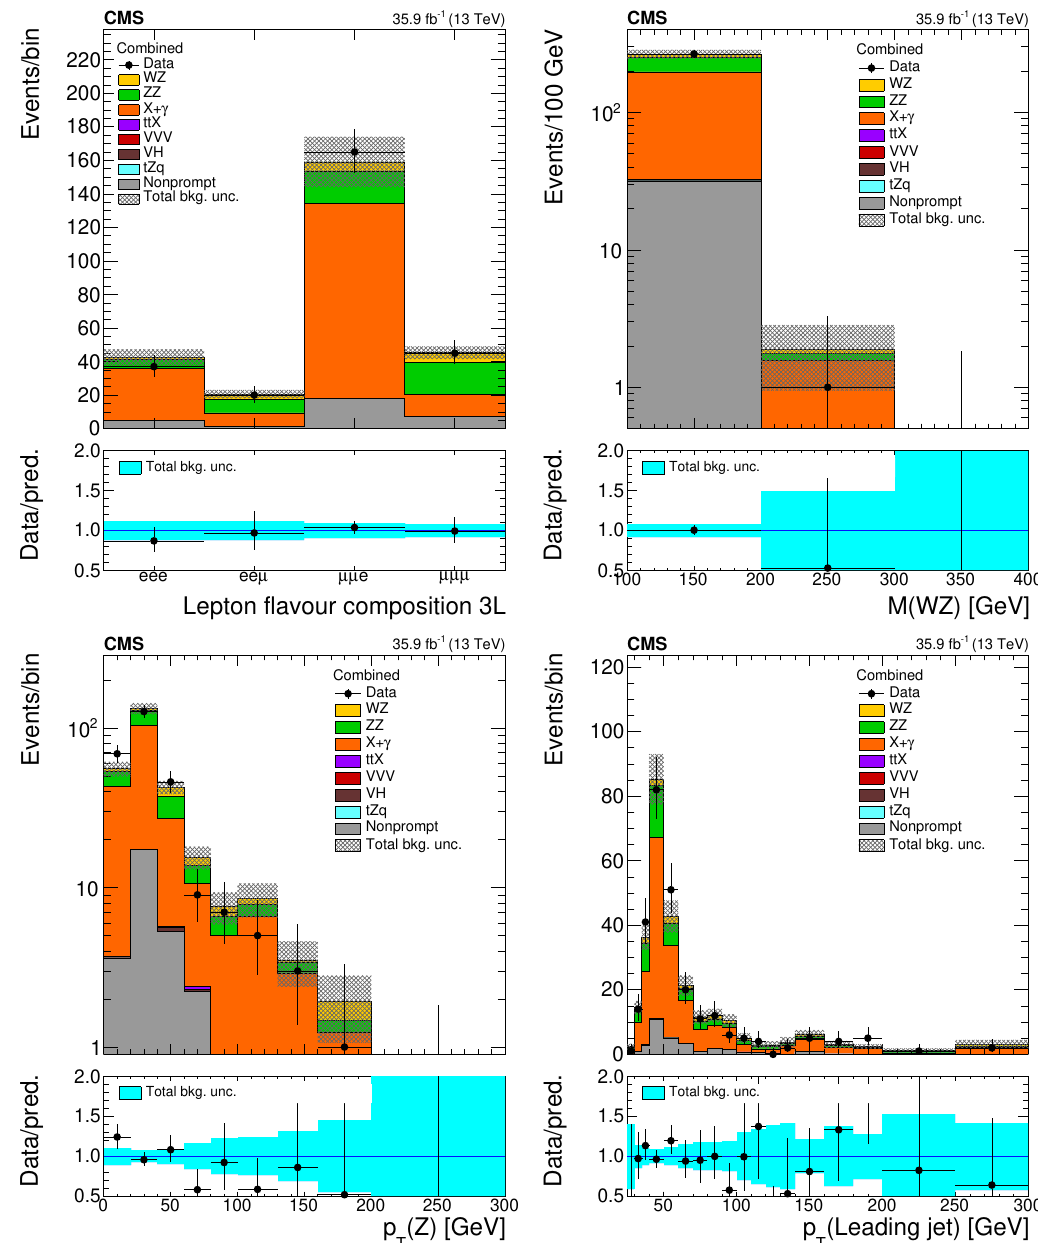
Figure 5 . Distribution of key observables in the conversion control region de(cid:12)ned in table 1: (cid:13)avour composition of the three leading leptons (top left), invariant mass of the three lepton plus missing transverse momentum (top right), transverse momentum of the Z boson reconstructed from the p T of the two leptons assigned to it (bottom left), and transverse momentum of the leading jet (bottom right). Vertical bars on the data points include the statistical uncertainty and shaded bands over the prediction include the contributions of the di(cid:11)erent sources of uncertainty evaluated after the signal extraction